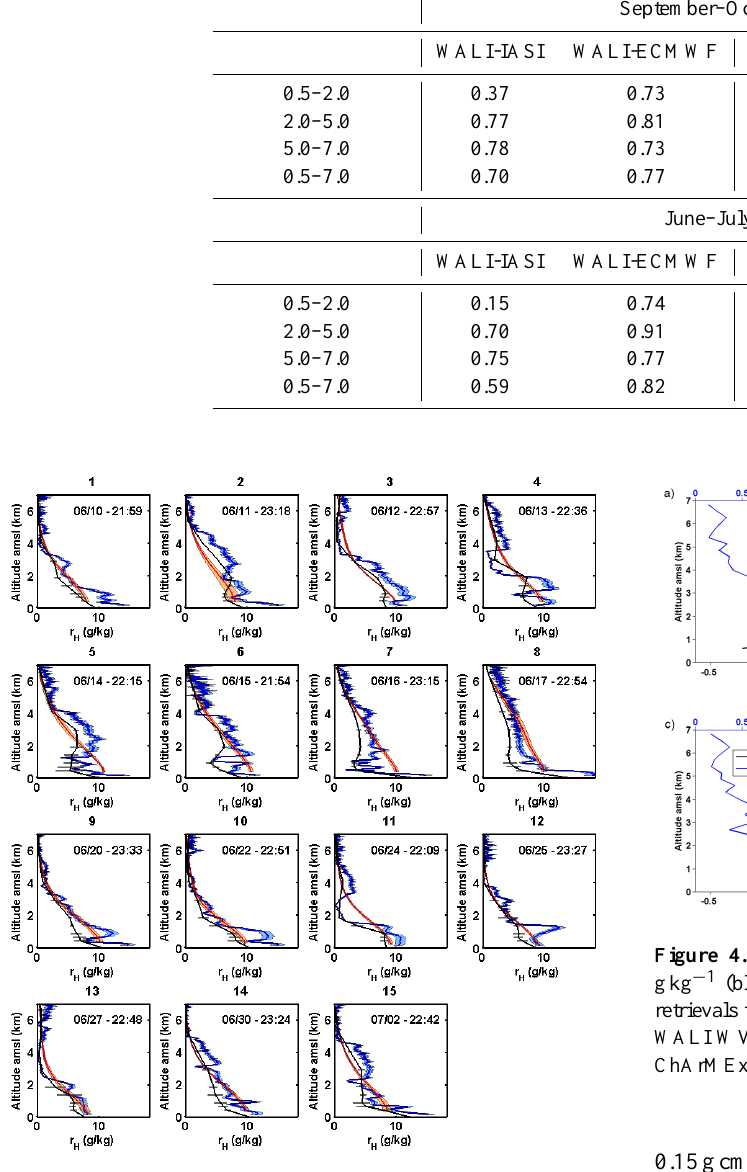
Figure 3. Same as Fig. 2 for the ChArMEx experiment (June and July 2013).